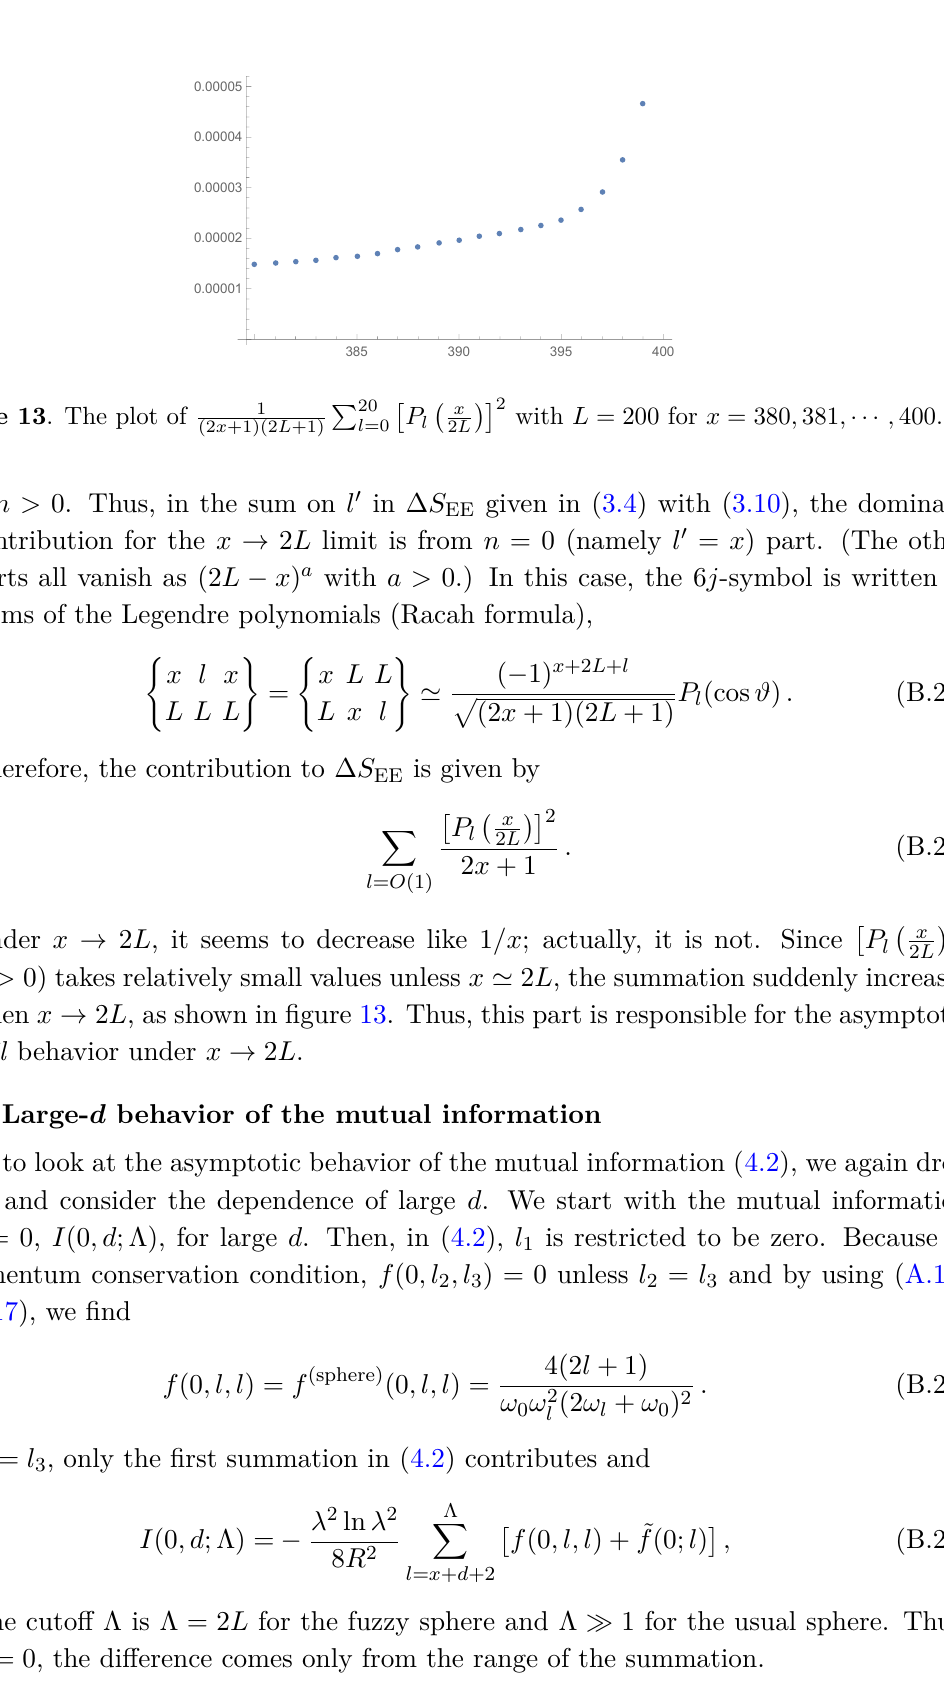
Figure 13 . The plot of 1